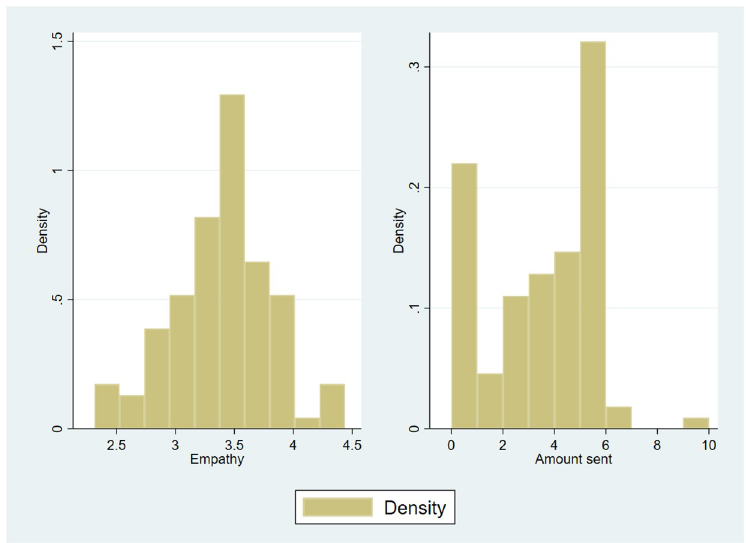
Fig 2. Distribution of empathy and prosocial behavior. Distribution of empathy (left panel) and prosocial behavior measured by the amount sent in the first stage dictator game (right